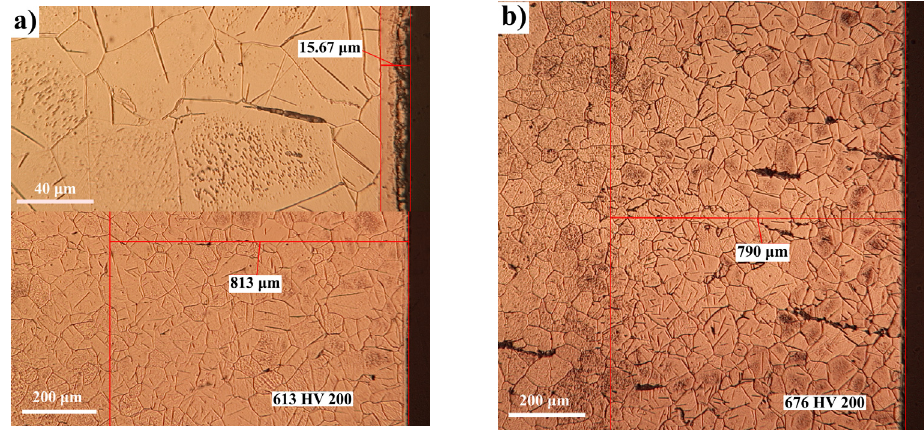
Figure 4. OM of nitrided Fe-ARMCO at 580 °C/4 h in an atmosphere of ammonia diluted with nitrogen in a proportion of 30% ( a ), respectively, 60% ( b ); degree of ammonia dissociation: 45% ( a ) and 70% ( b ); nitrogen potentials: 1.64 ( a ) and 0.56 ( b ); N 2 concentrations in the surface areas of the layers: 8.5% ( a ) and 7.58% ( b ). The microhardness indentations were performed at 150 microns from the surface of the layer.